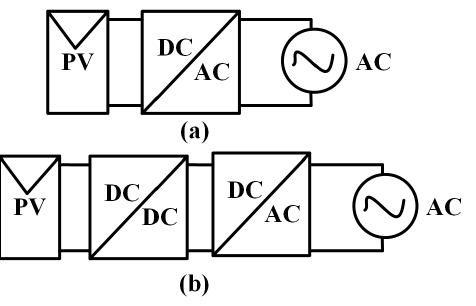
Figure 1. Types of PV inverters: ( a ) single stage, ( b ) multi stage [5]. The boosting voltage level, processing of the maximum power point tracking (MPPT), and injected voltage waveform are included in the system capabilities shown in Figure 1.